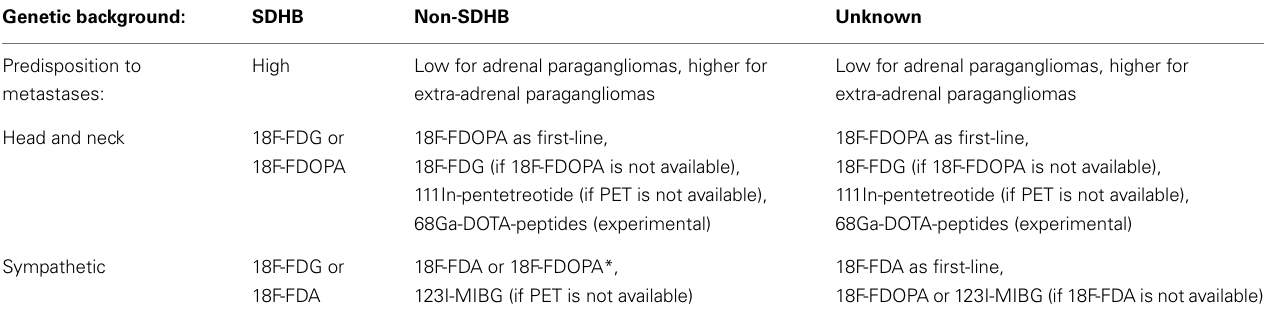
Table 2 | Suggested functional imaging modalities for paragangliomas, in relation to genetic background and location of primary tumor. Genetic